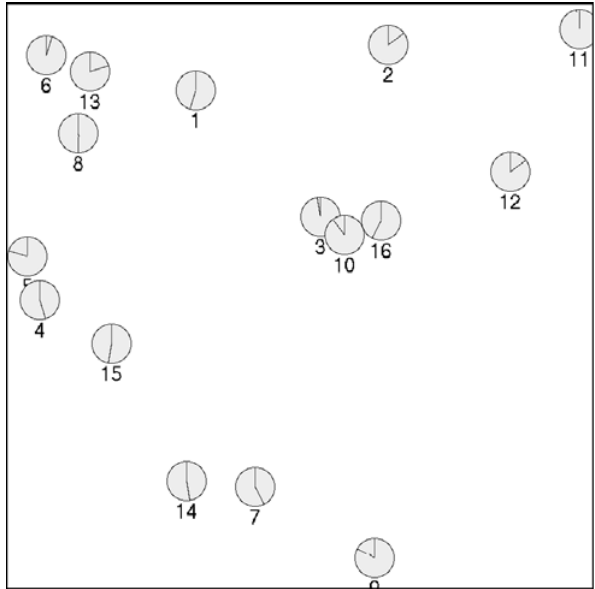
Figure 1. An example Nomon application for selecting between 16 points on screen (screenshot). The horizontal and vertical positions of the option points were chosen uniformly at random in the box shown to illustrate the flexibility of the method.